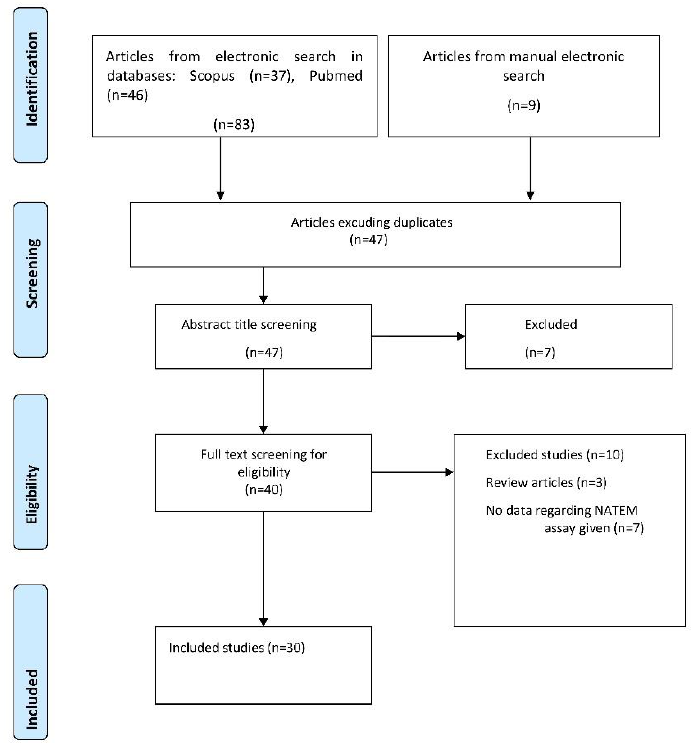
Figure 1. Flowchart of the literature review process.